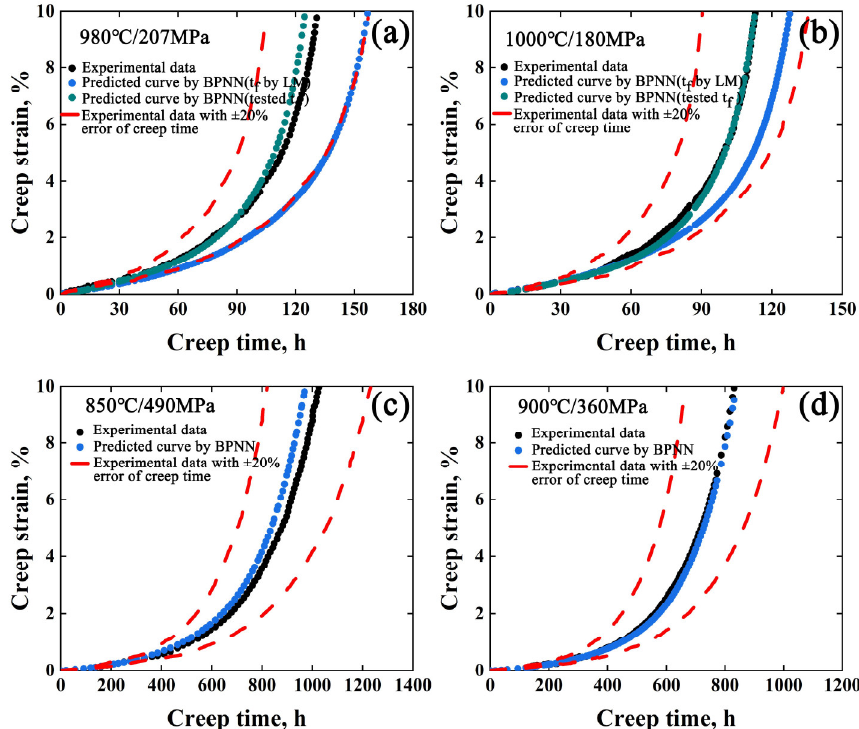
Figure 3. The results by BPNN model for DZ125 superalloy and CMSX-4 superalloy: ( a , b ) comparison of predicted and experimental values under 980 °C/207 MPa and 1000 °C/180 MPa for DZ125 superalloy, ( c , d ) comparison of predicted and experimental values under 850 °C/490 MPa and 900 °C/360 MPa for CMSX-4 superalloy.